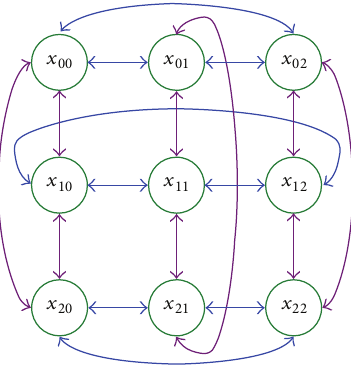
Figure 1: Architecture of model